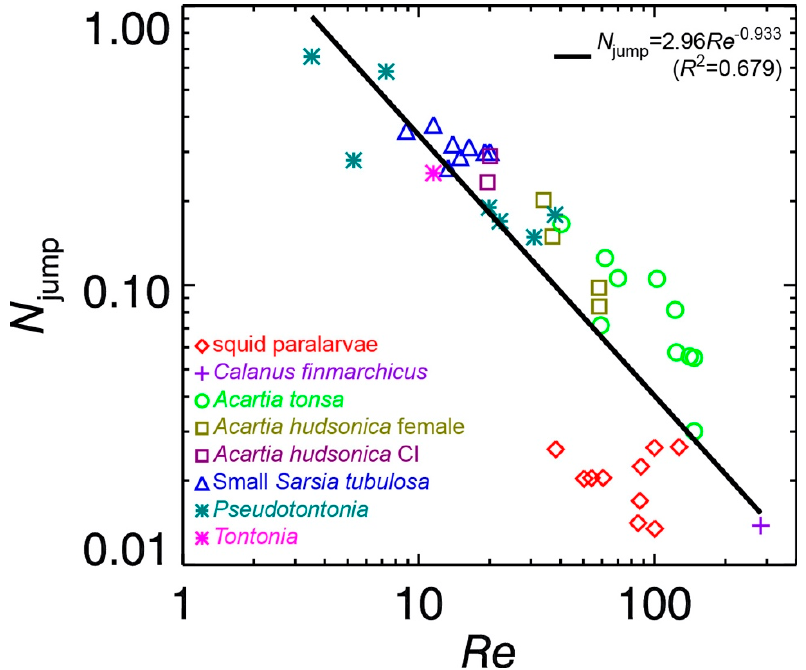
Figure 3. The nondimensional jump number ( N jump ) as a function of the Reynolds number ( Re ≡ U max L / ν , where U max is the maximum jumping speed, L = (body length + tail length)/2 for Pseudotontonia and Tontonia , and L = body length for all other species). For the copepod Acartia tonsa , data were obtained by [13]. For the small medusa Sarsia tubulosa , data were obtained by [16]. For the ciliates Pseudotontonia sp. and Tontonia sp., data were obtained by [18].